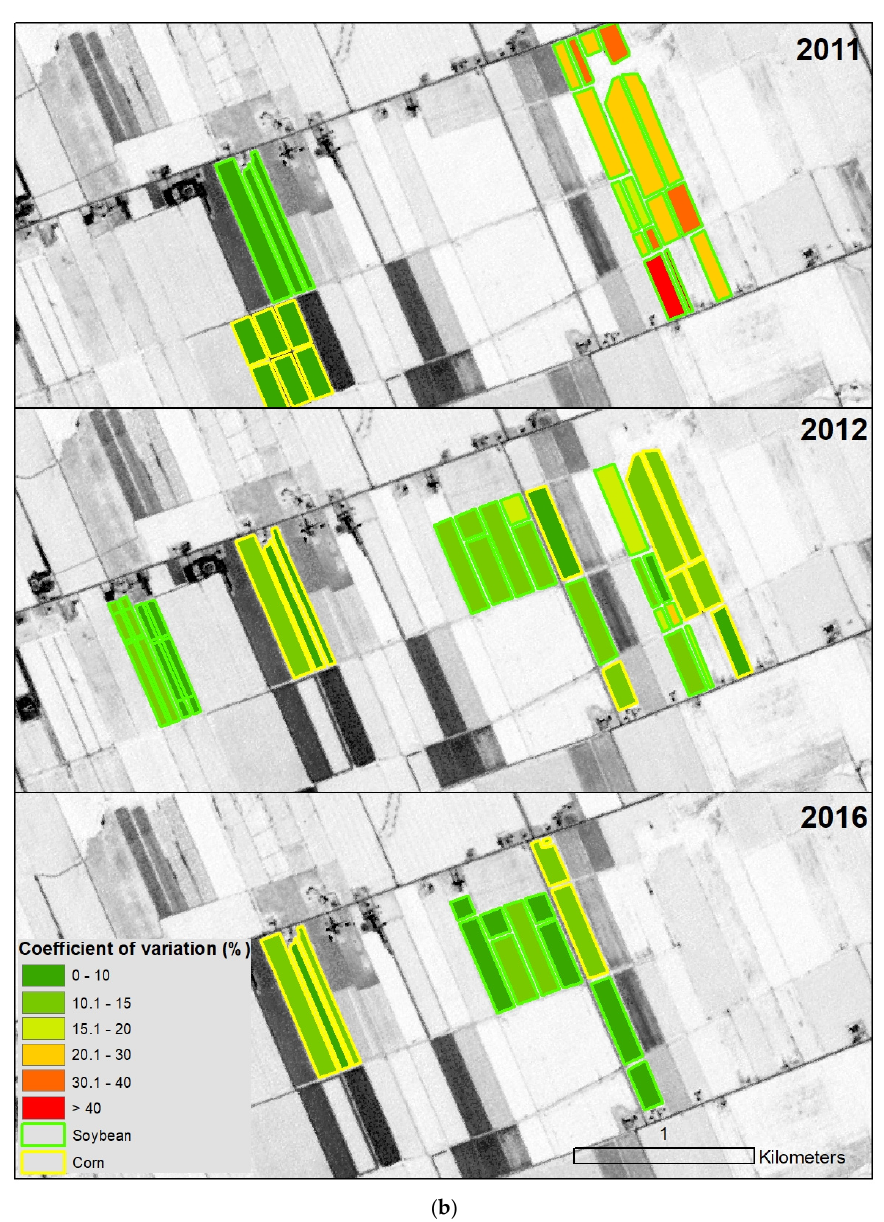
Figure 2. ( a ) Overview of corn and soybean yield variability across fields in 2011, 2012 and 2016. ( b ) Overview of corn and soybean yield variability across fields in 2011, 2012 and 2016. Color classes refer to the coefficient of variation (CV) of the observed yield within each field.